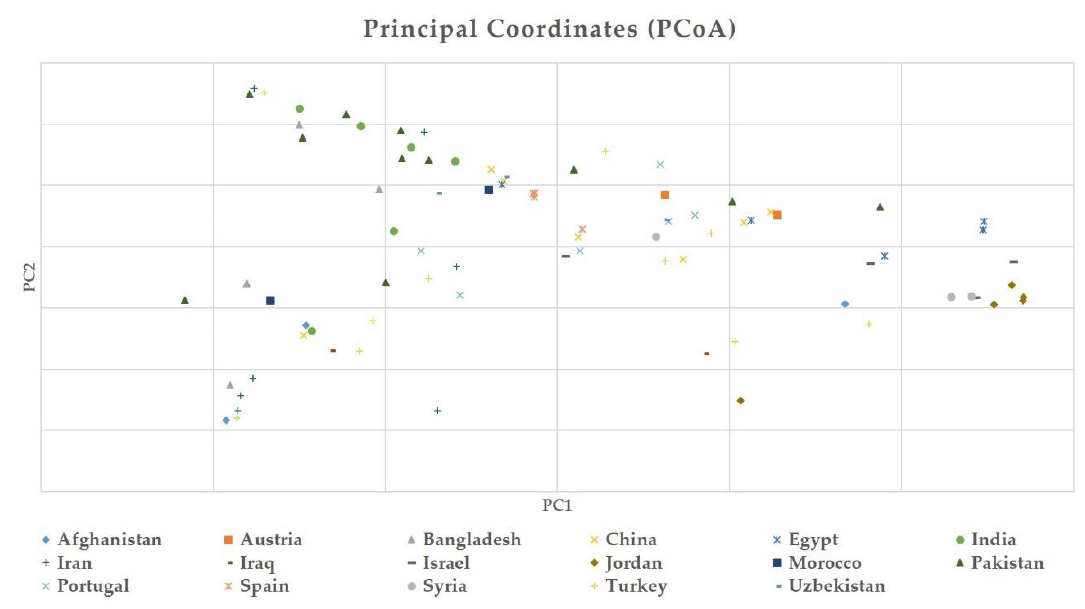
Figure 8. Principal coordinate analysis (PCoA) of the 94 safflower accessions using silicoDArT molecular markers.